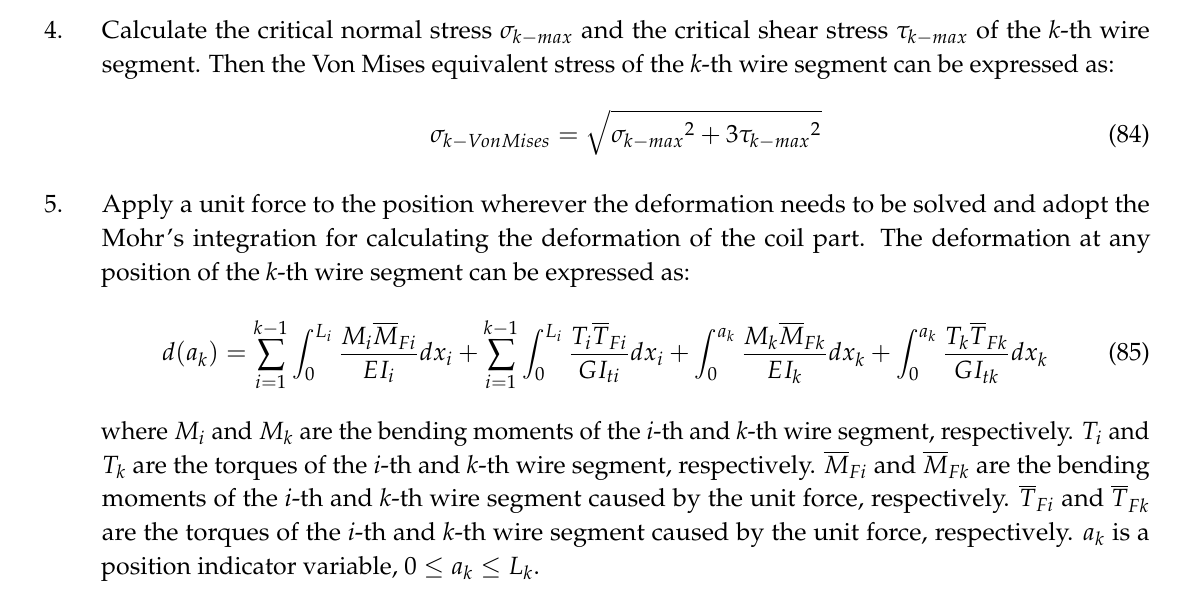
Figure 16. Maximum deformation as calculated by ANSYS and the proposed model versus shock load amplitude.